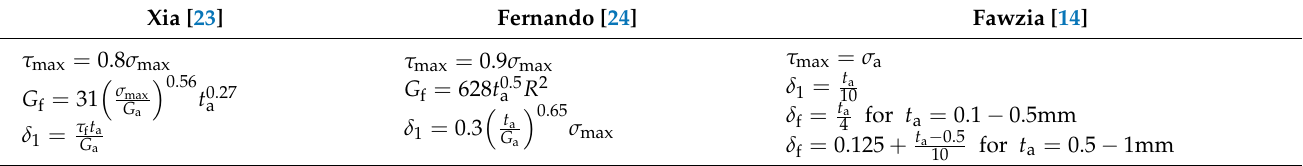
Table 3. Expressions of Parameters of Different Bond–Slip Models.